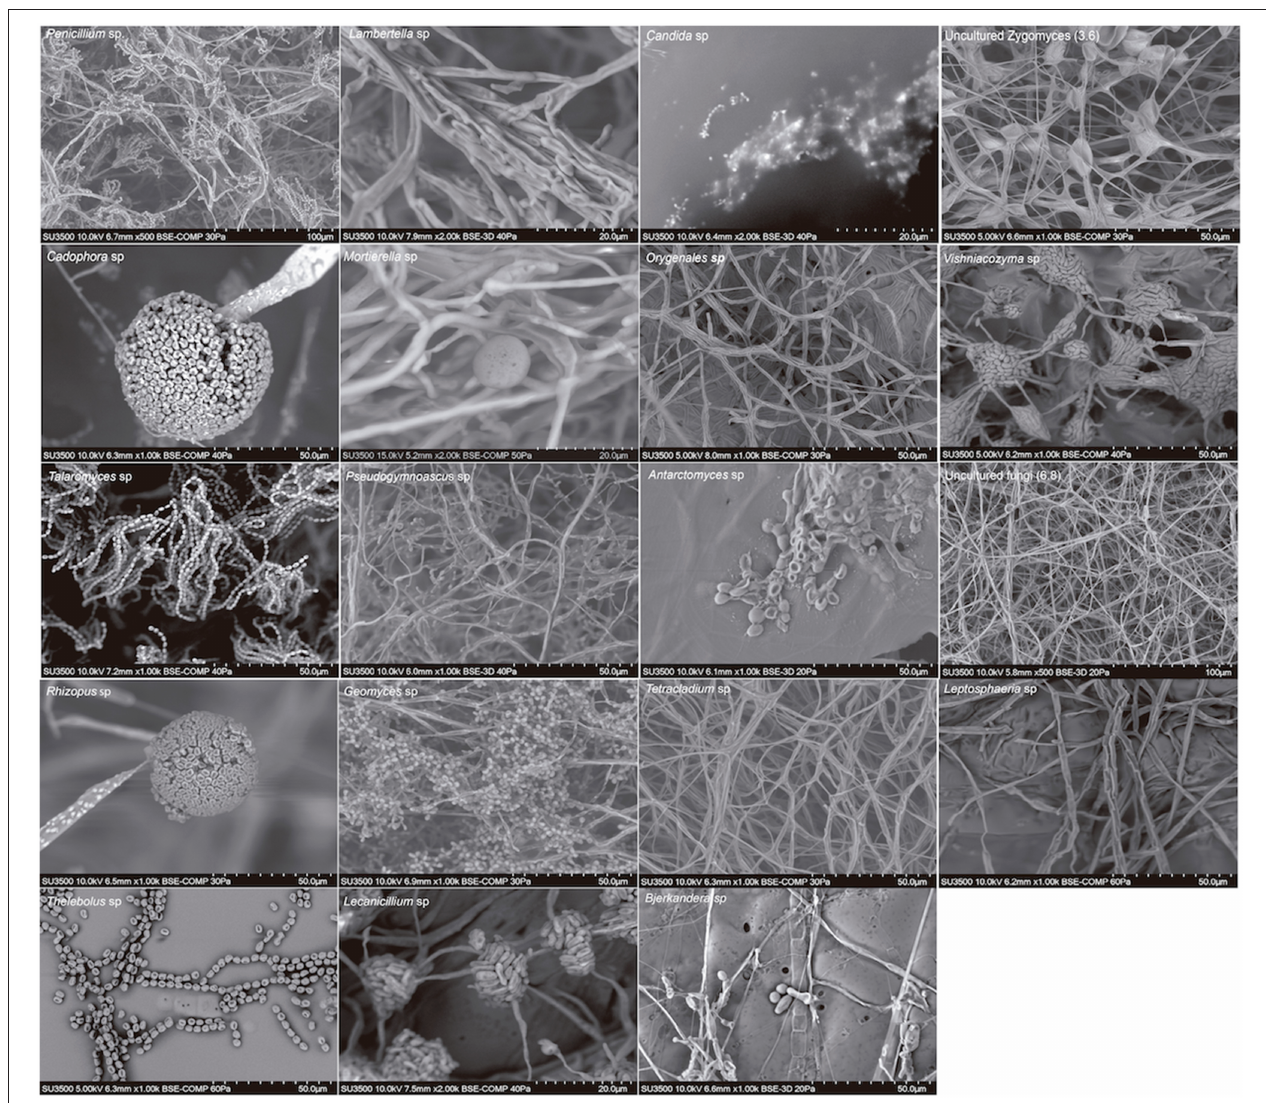
FIGURE 3 | Scanning electron micrographs of genera of cultivable fungi isolated from South Shetland